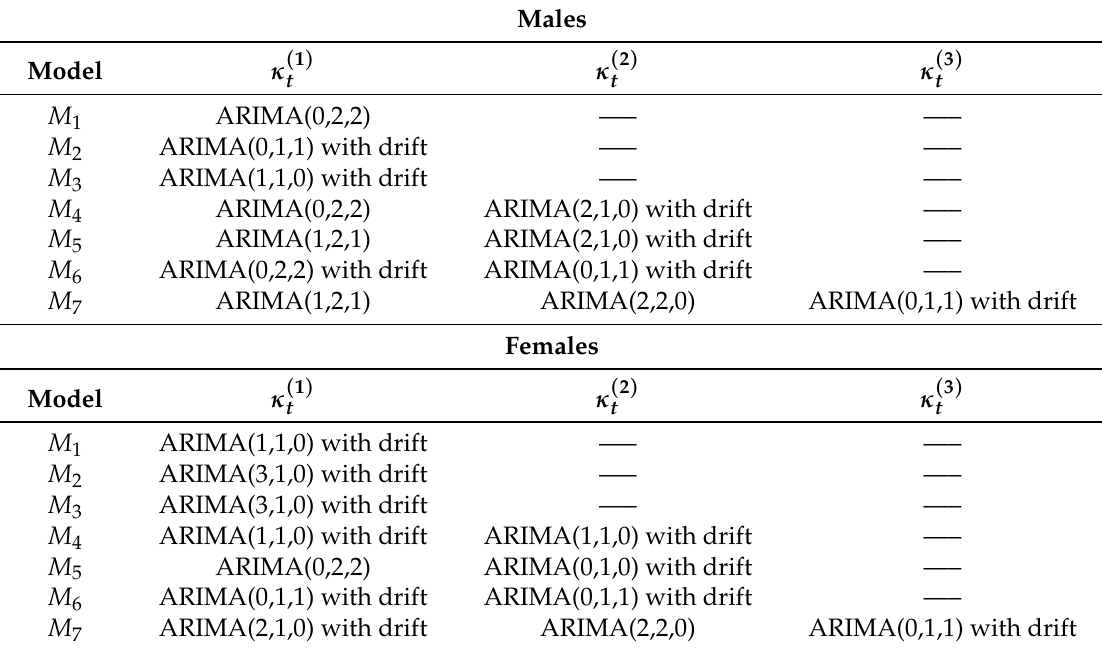
Table 4. Selected ARIMA(p,d,q) models for the period index κ mortality models.